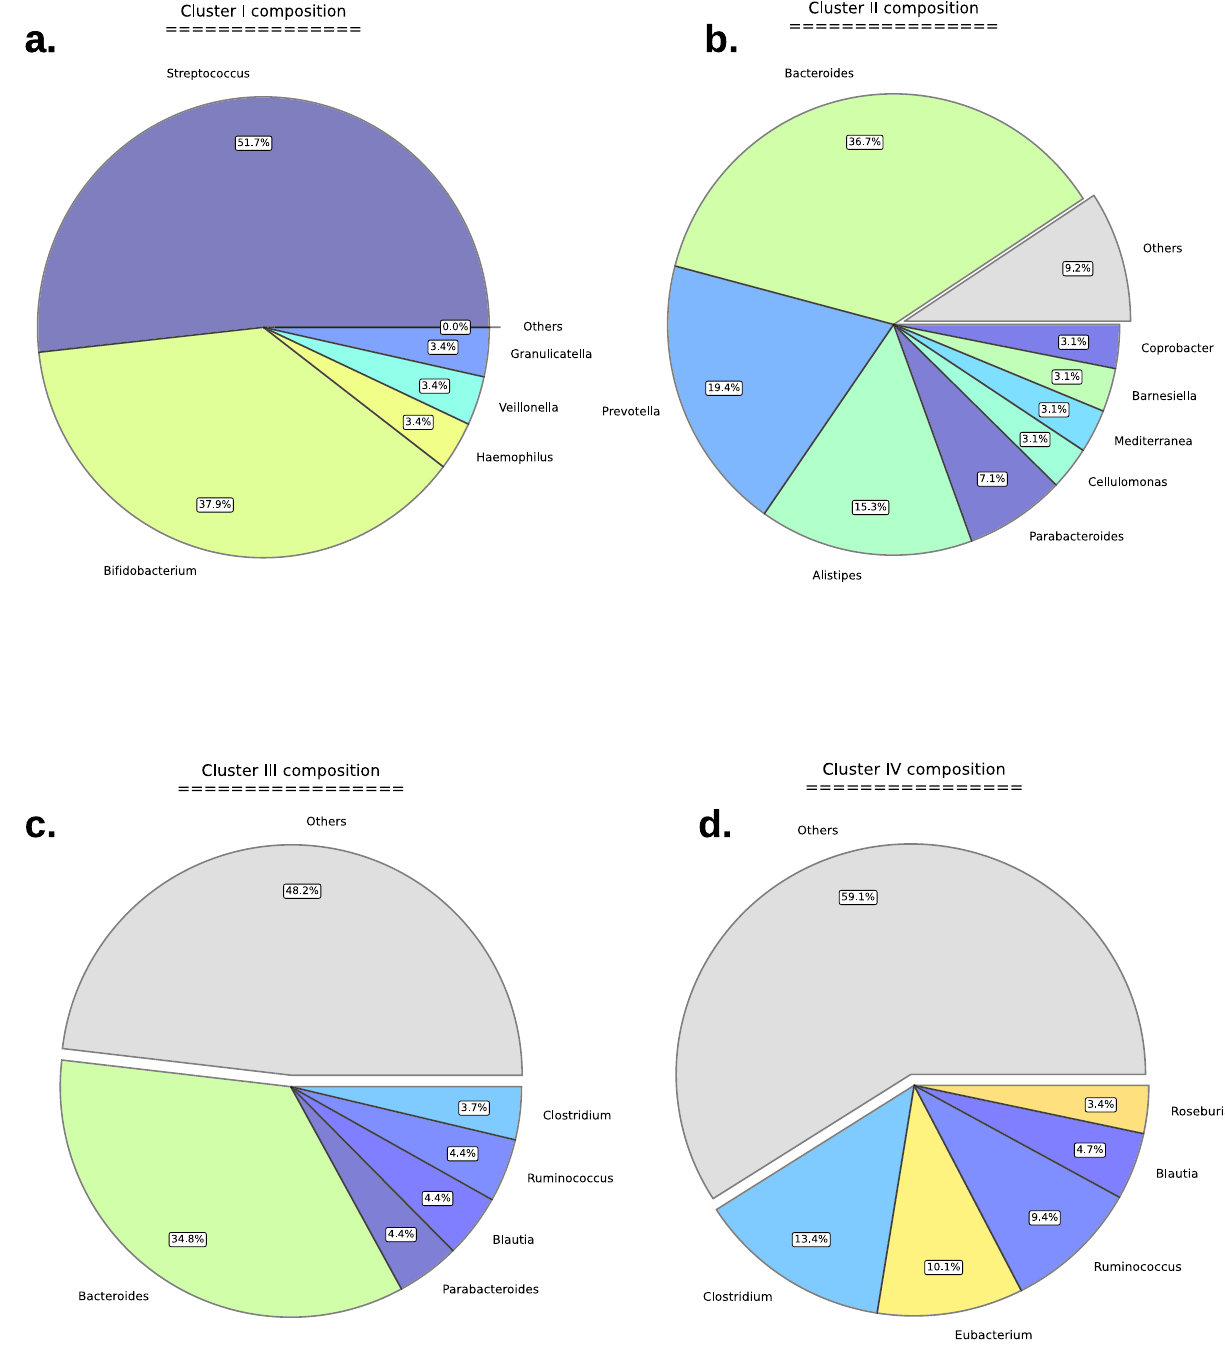
Figure 5. Pie plots of the cluster taxonomy. Pie plots demonstrating genus-level taxonomic compositions within each of the module clusters. Clusters were determined using PCA of module functional profiles for each module. ( a ) Cluster I is dominated by members of the S treptococcus and Bifidobacterium genera and no genus represents less than 3% relative abundance. ( b ) Members of the Bacteroides genus are also the most abundant in the Cluster II, however the Prevotella and Allistipes genera are also abundant and account for > 70% of abundance when combined with Bacteroides . There are 6 genera with relative abundances below 3%. ( c ) Members of the Bacteroides genus are the most abundant in the Cluster III and there are 49 genera with relative abundances below 3%. ( d ) There are only 5 genera above 3% relative abundance and 44 genera below 3% with no one genus showing greater than 15% relative abundance. Genera with < 3% relative abundance were placed in the ‘Others’